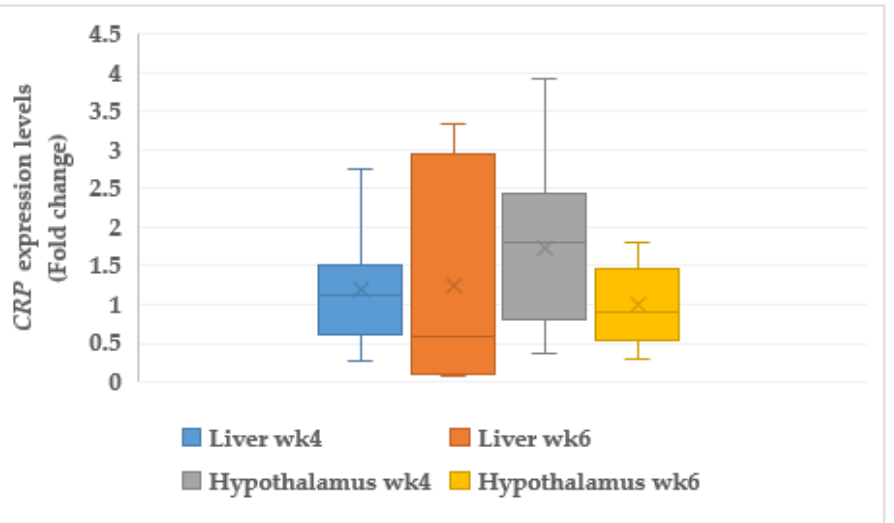
Figure 5. Expression profile of C-reactive protein ( CRP ) in the muscle, liver, and heart at week 4 and 6 in corticosterone fed chickens (fold-change). wk4 = 4 weeks of age (2 weeks of CORT administration; wk6 = 6 weeks of age (4 weeks of CORT administration); n = 20.